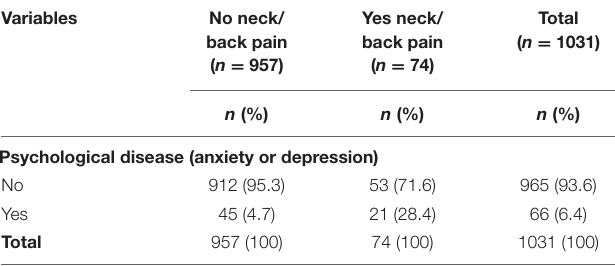
TABLE 4 | Comparison between presence or absence of psychological disease (anxiety; depression) according to Neck/Back pain status in the Al-Kharj population sample ( n = 1,031).